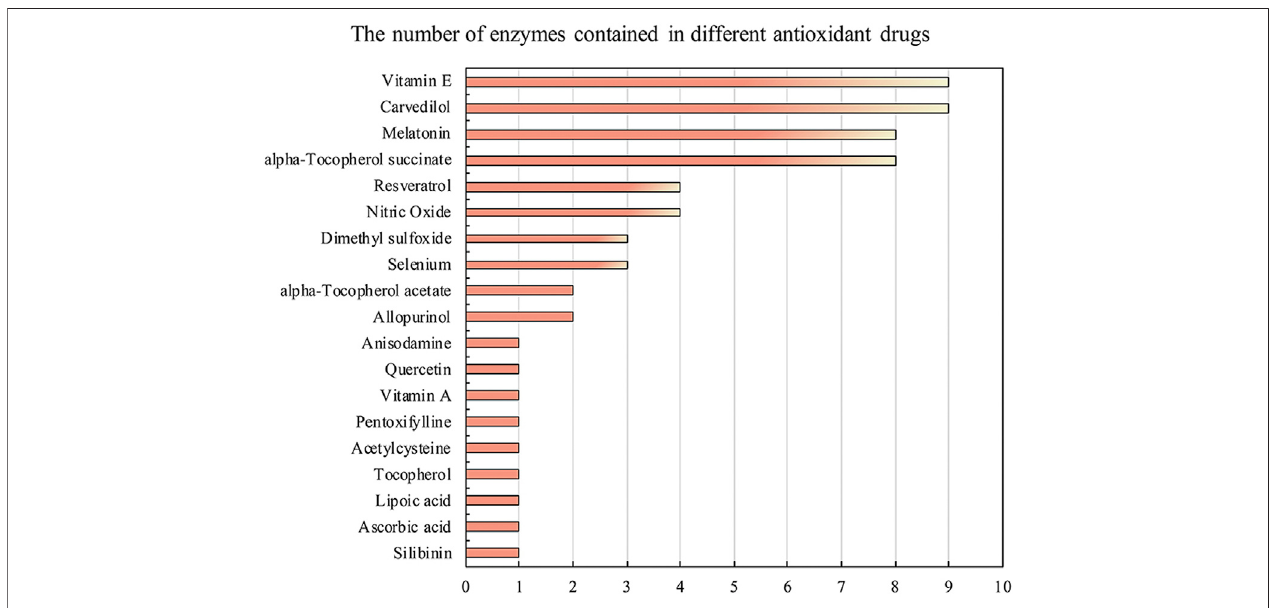
FIGURE 1 | The function structure of